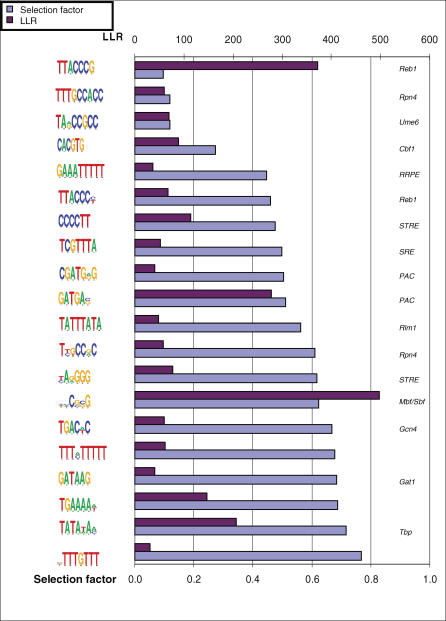
De Novo ModelShown are the LLR and selection factor values for the 20 target k-mer sets with the highest LLR values as discovered in the de novo model. The full model is presented in Table S2. For each target k-mer set, we present its motif logo, and, when the set matches a published binding site motif, its most likely TF. Target k-mer sets are sorted according to selection factor, indicating many of the known TFs as having relatively high factor and weak selection. Also shown is the LLR of each target k-mer set, which is affected by both the number of motif appearances and their divergence properties.